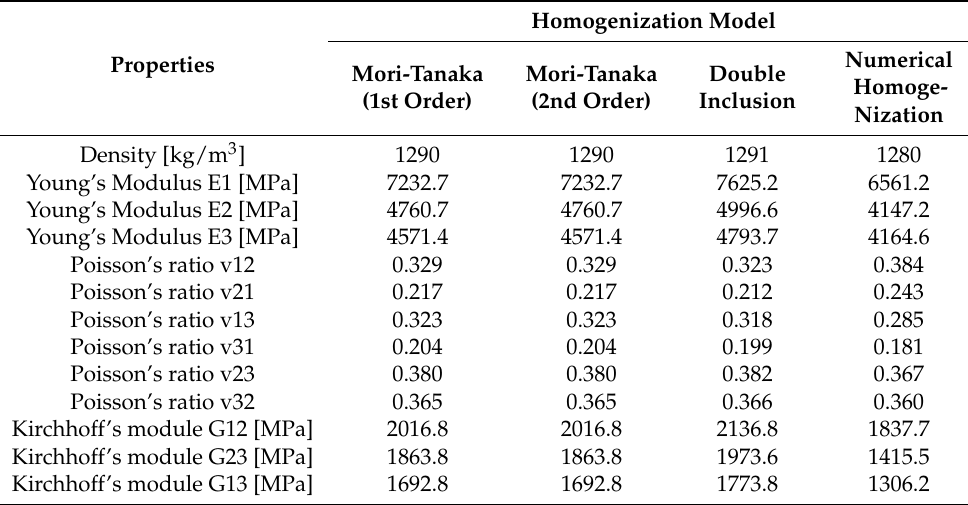
Table 10. The predicted mechanical properties of the biocomposite PHBV-hemp fiber (K30) for a variable homogenization